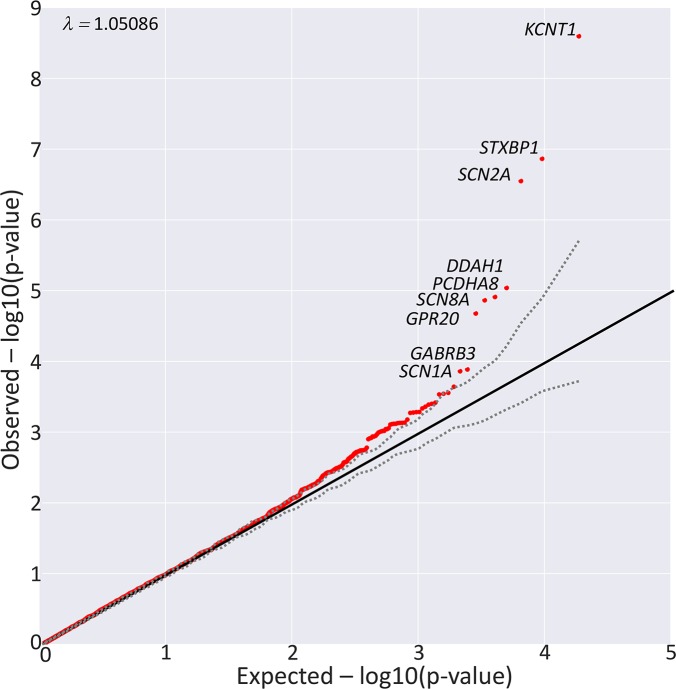
A. Quantile-quantile (QQ) plot for genome-wide gene-based collapsing analysis. The Y-axis represents -log10 of observed (red) p-values (sorted) evaluated in the logistic regression adjusting for the total number of “ultra-rare” synonymous variants per individual; the X-axis represents -log10 of expected p-values (sorted) evaluated in the same logistic regression model with permutation (“BiasedUrn”). The dashed grey lines indicate permutation-based 95% confidence intervals.